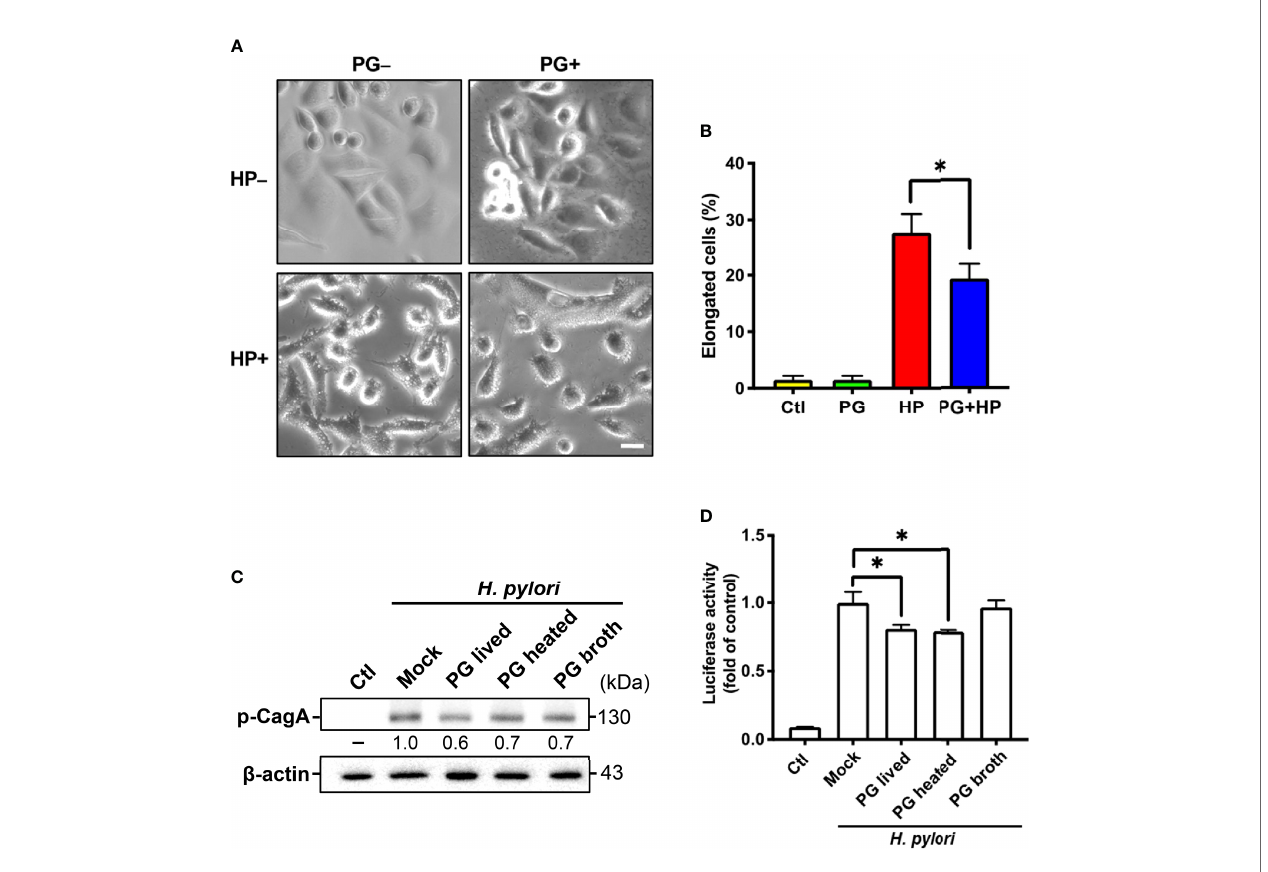
FIGURE 10 | P. goldsteinii MTS01 ameliorates H. pylori -induced pathogenesis. (A) AGS cells were pretreated with P. goldsteinii MTS01 for 30 min and then infected with H. pylori at an MOI of 100 for 6 h. Cell vacuolation and elongation were observed by using a phase-contrast microscope. (B) The proportion of elongated cells were counted. (C) CagA phosphorylation were analyzed by western blot assay. Relative protein expression levels were normalized to b -actin and indicated under each lane. (D) The level of NF- k B activation was assessed using luciferase assay. * P <